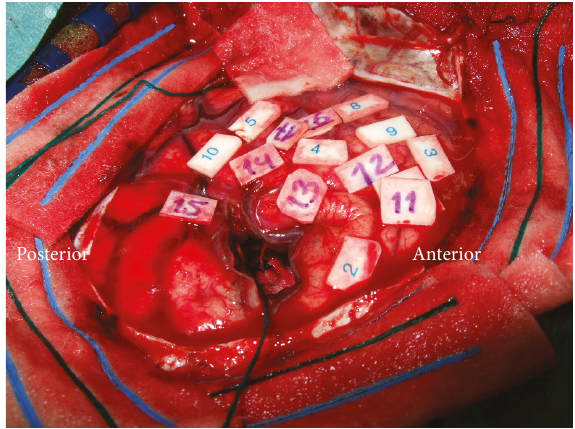
Figure 4: Resection cavity